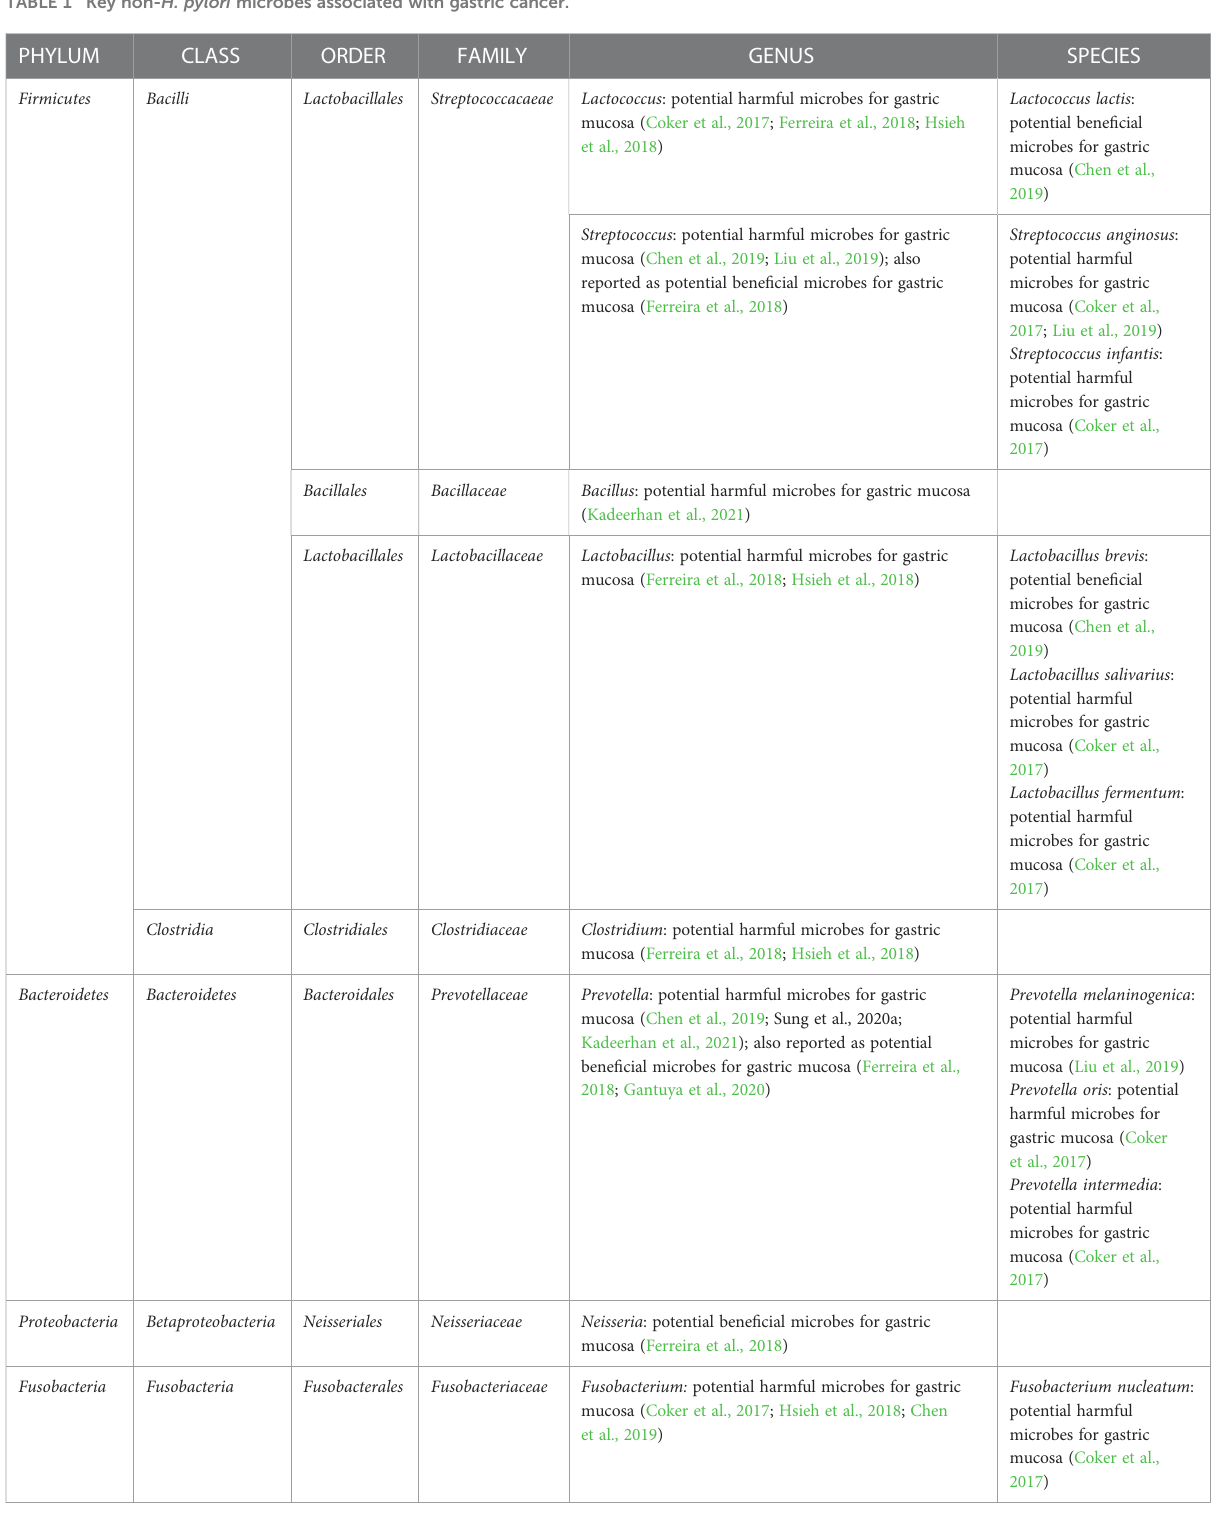
TABLE 1 Key non- H. pylori microbes associated with gastric